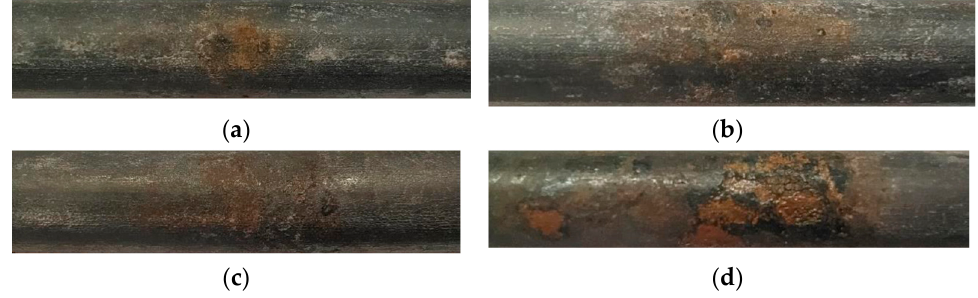
Figure 23. Pit formation of the steel rods from the 3D-0 ( a ), 3D-10, ( b ), 3D-(20) ( c ) and 3D-30 ( d ) beams.